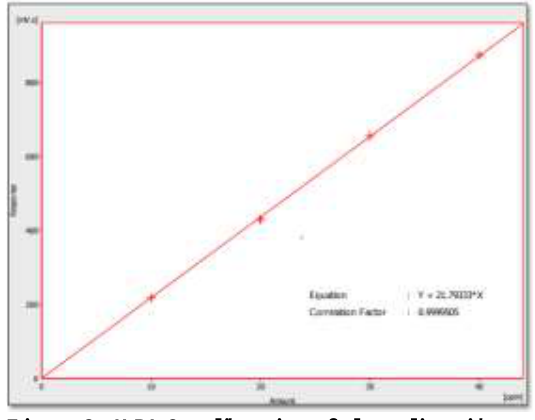
Figure 3. HPLC calibration of oleanolic acid standard